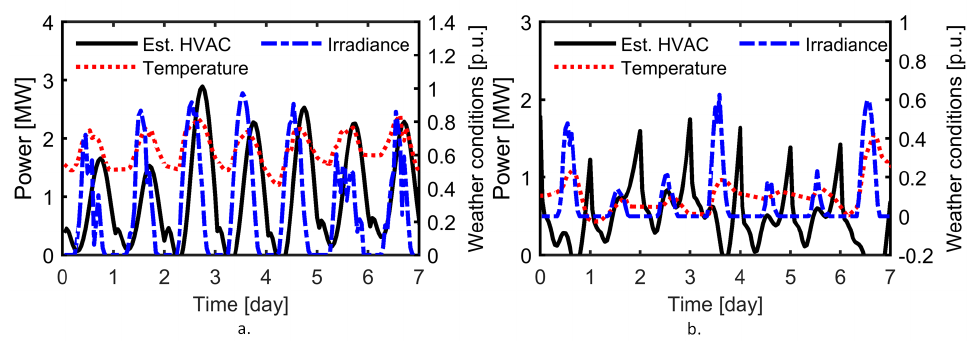
Figure 7. HVAC electric power component dissagregated as the difference between the total fore- casted power from Figure 5 and the estimated baseload power from Figure 6 for summer ( a ) and winter ( b ).